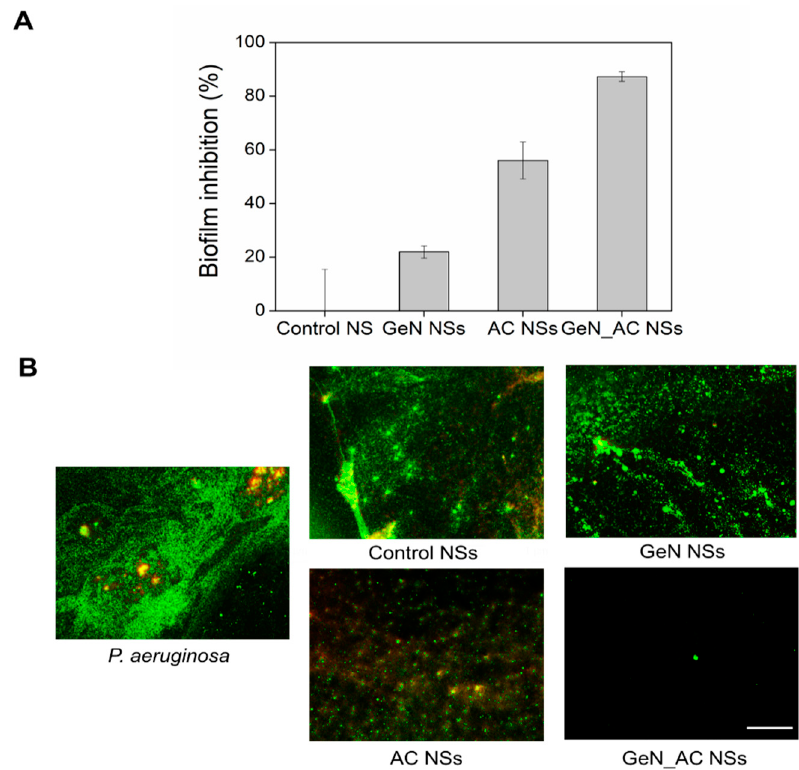
Figure 4. Inhibition of P. aeruginosa biofilms by control, AC, GeN and GeN_AC NSs (0.125 × 10 13 NSs mL − 1 ). ( A ) Total biomass determination with crystal violet; ( B ) Fluorescence microscopy images of live (green) and dead (red) bacteria in the biofilms. The green and red fluores- cence images are overlaid. Scale bar corresponds to 100 µ